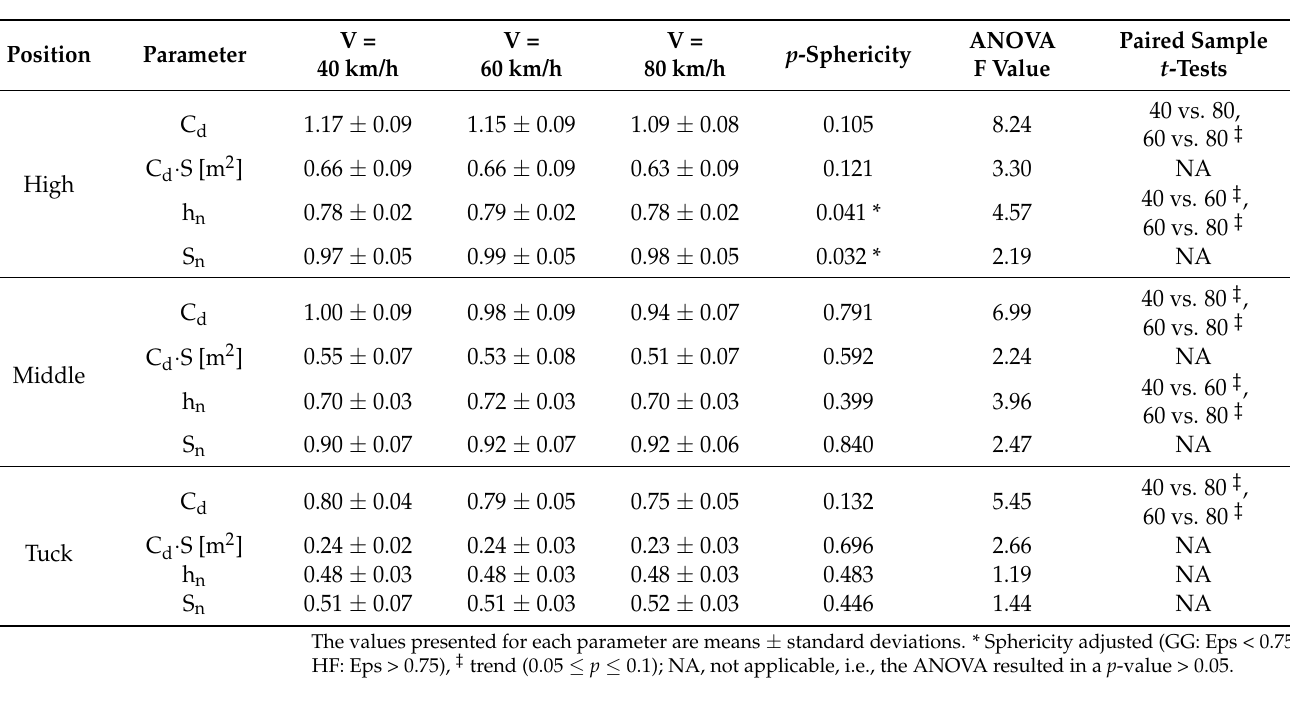
Table 2. Comparison of the coefficient of aerodynamic drag (C d ), the product of this coefficient, and the skier’s cross-sectional area (C d · S) and normalized shoulder height (h n ) and cross-sectional area (S n ) at three different wind speeds (V = 40, 60, and 80 km/h) in the three skiing positions (high, mid, and tuck).